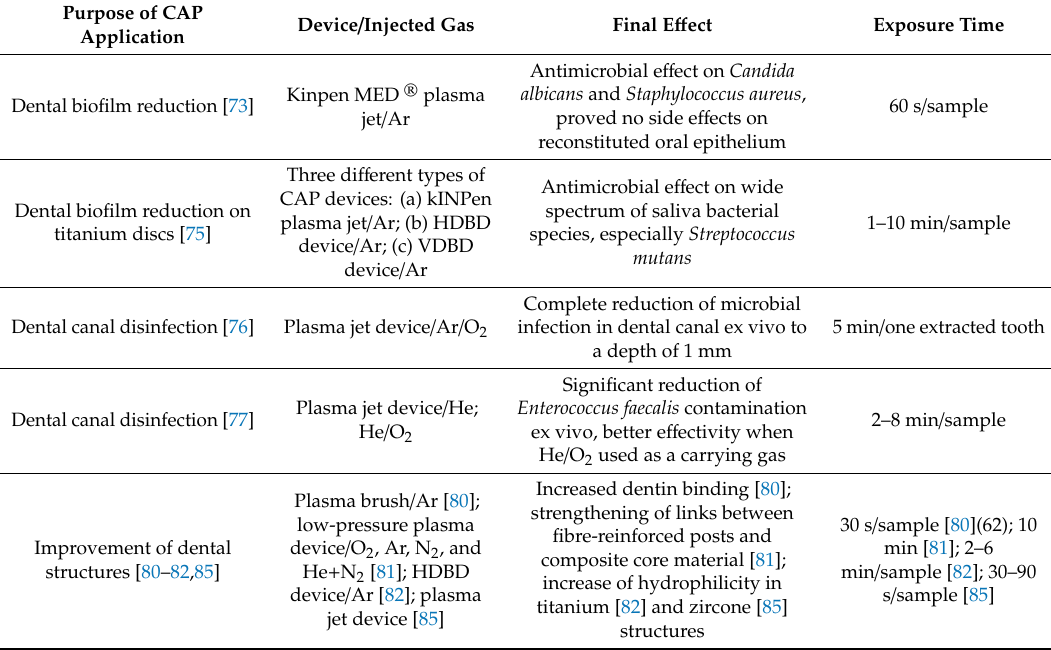
Table 3. List of cold atmospheric plasma (CAP) application e ff ects to dental and oral cavity structures under in vitro and ex vivo